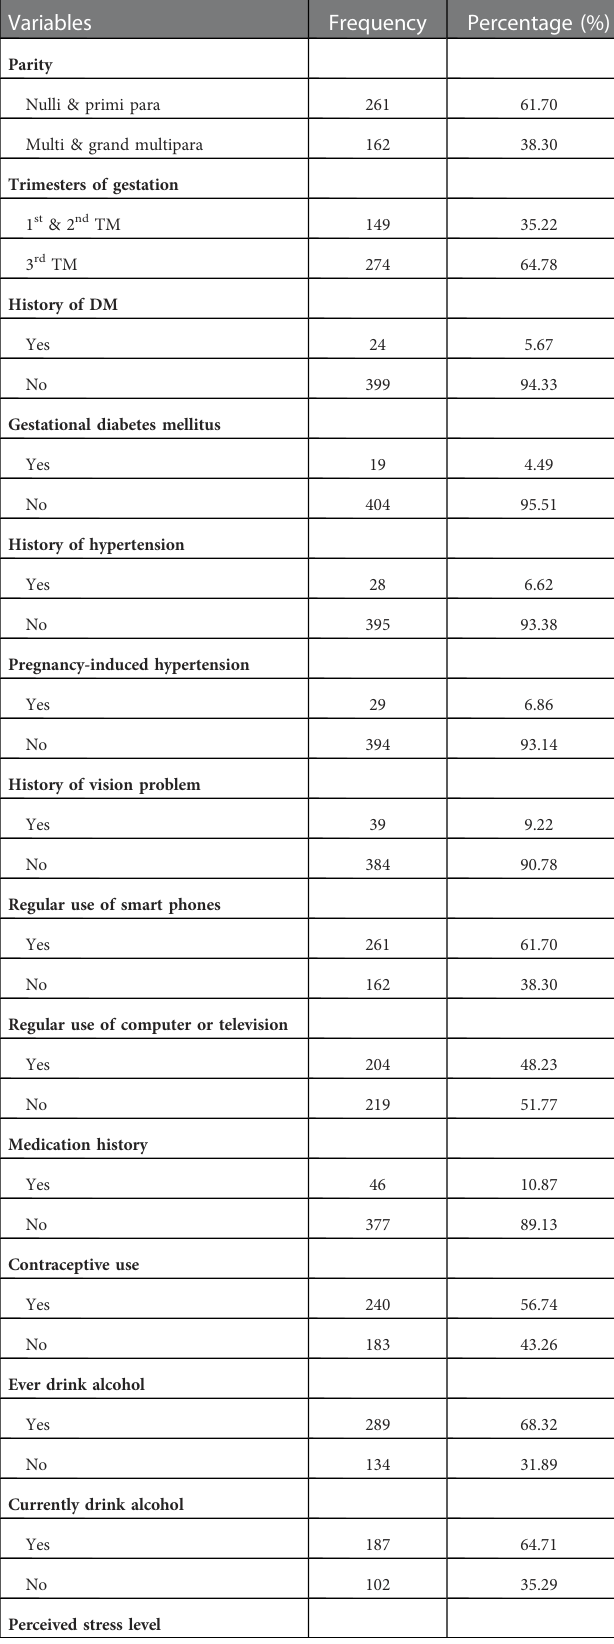
TABLE 2 Lifestyle, clinical, and obstetric-related characteristics of pregnant women attending ANC units at governmental health institutions in Gondar District, Northwest Ethiopia, 2021 ( n